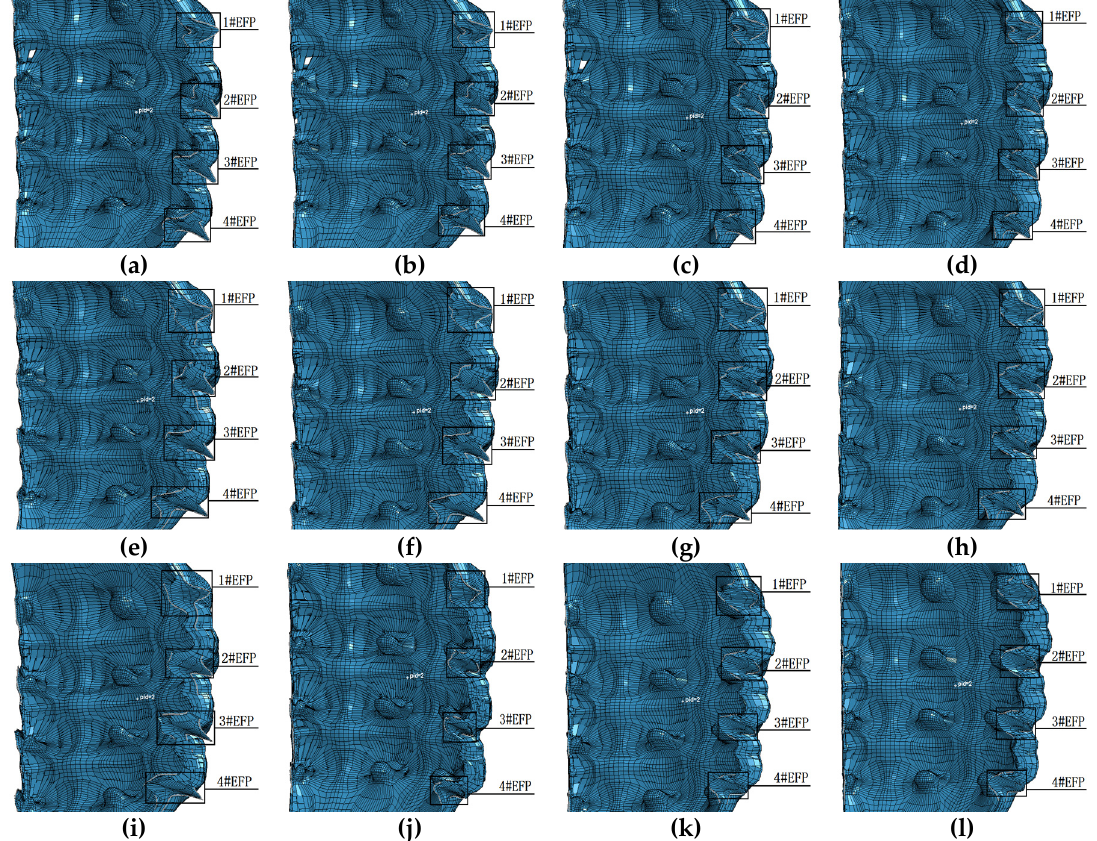
Figure 13. 1#EFP-4#EFP formed shape of the liner which different curvature radius of outer wall and different center thickness:( a ) R1 = 12 mm, R2 = 8 mm, ∆ t = 1.0 mm; ( b ) R1 = 12 mm, R2 = 9 mm, ∆ t = 1.0 mm; ( c ) R1 = 12 mm, R2 = 11 mm, ∆ t = 1.0 mm; ( d ) R1 = R2 = 12 mm, ∆ t = 1.0 mm; ( e ) R1 = 12 mm, R2 = 8 mm, ∆ t = 1.15 mm; ( f ) R1 = 12 mm, R2 = 9 mm, ∆ t = 1.15 mm; ( g ) R1 = 12 mm, R2 = 11 mm, ∆ t = 1.15 mm; ( h ) R1 = R2 = 12 mm, ∆ t = 1.15 mm; ( i ) R1 = 12 mm, R2 = 8